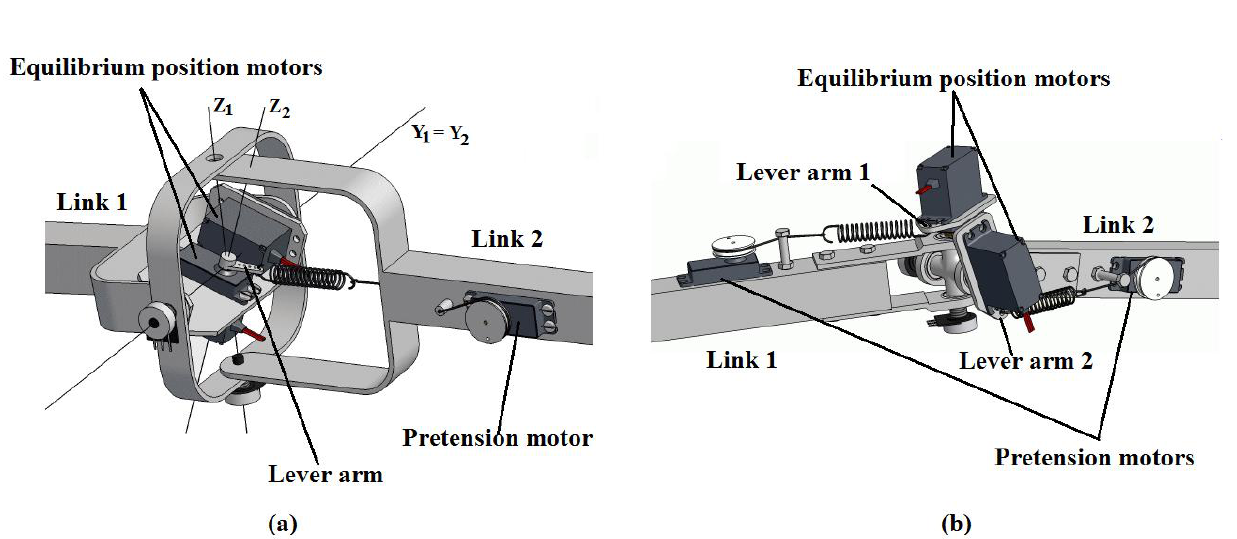
Figure 4. MACCEPA with two degrees of freedom and one variable stiffness ( a ) and a complete MACCEPA with two degrees of freedom and two independent variable stiffnesses ( b )